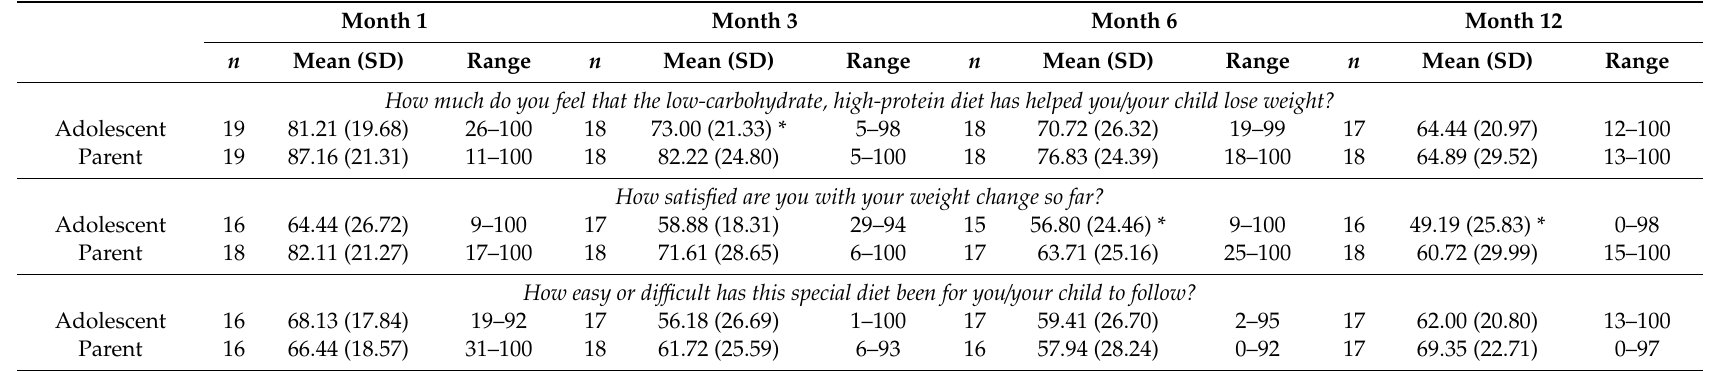
Table 4. Comparison of adolescent and parent satisfaction with the rPSMF over 12